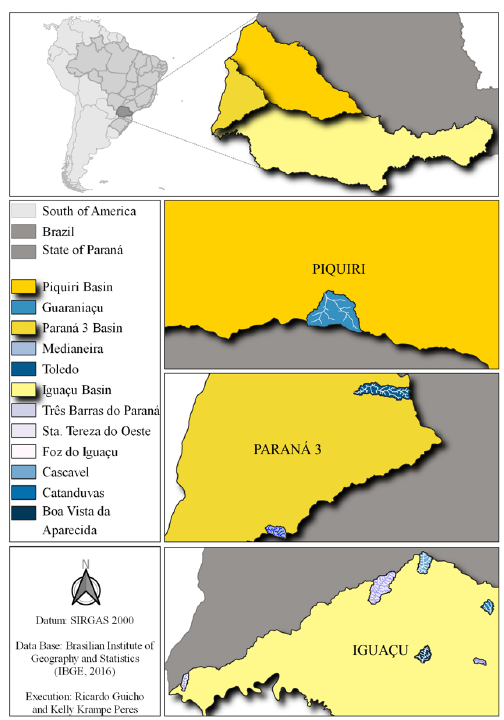
Figure 1. Municipalities in western Paraná, Brazil, selected to evaluate the water quality of rivers used for withdrawal and urban